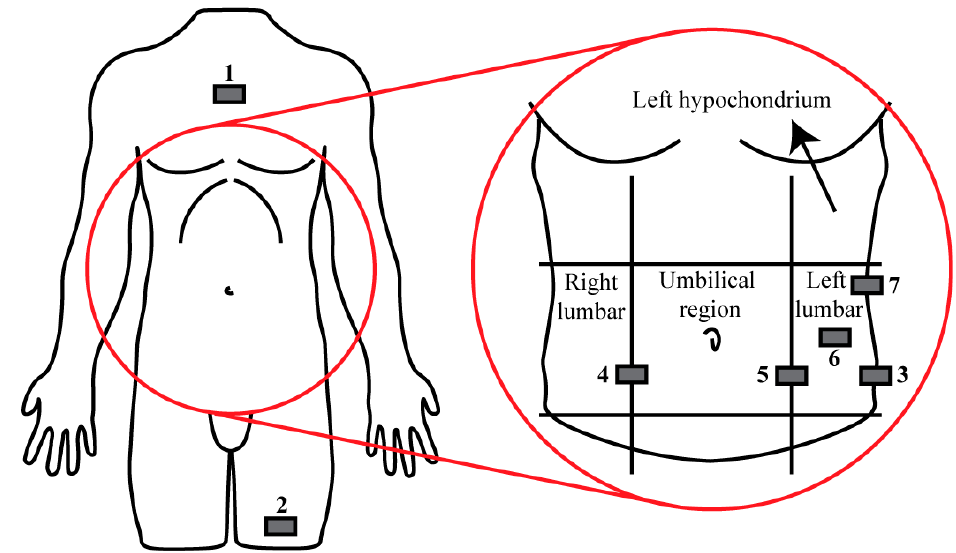
Figure 2. Schematic representation of the locations of the IMU placements (grey rectangles). Throughout the experiment, the sensor locations were coded with the following numbers: 1 = Sternum, 2 = Upper left leg, 3 = Left hip, 4 = Right umbilical, 5 = Left umbilical, 6 = Left lumbar, and 7 = Upper left lumbar.